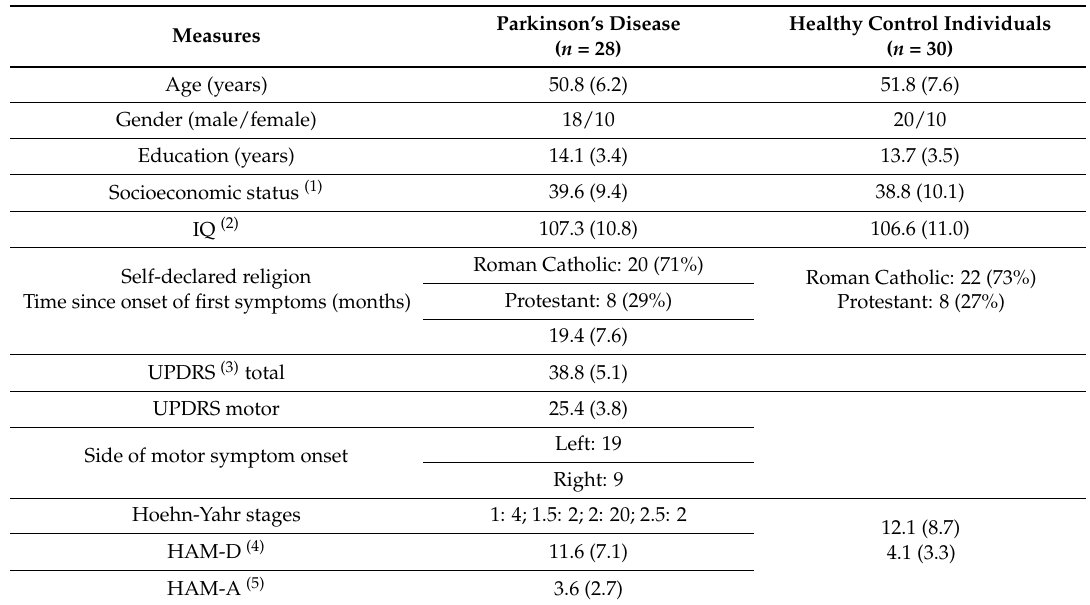
Table 1. Demographic and clinical characteristics of the